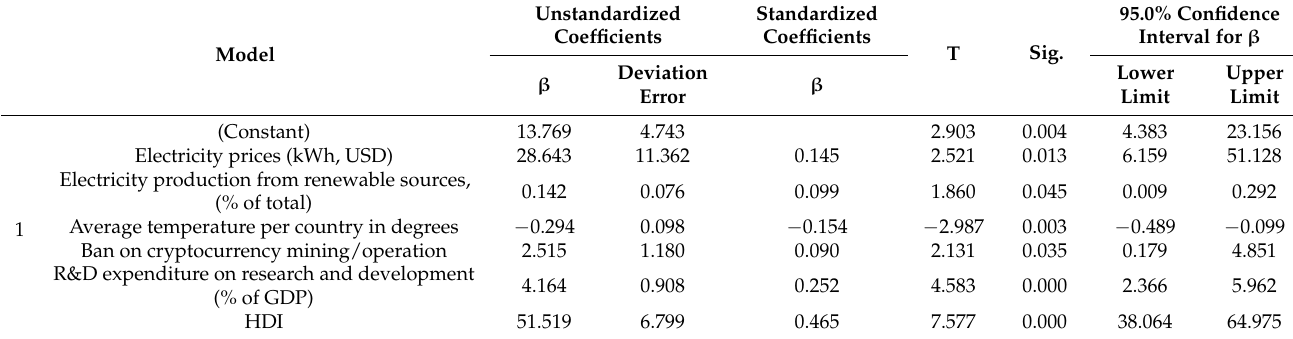
Table 3. Estimation of the parameters β of the model. Dependent variable: most sustainable country.